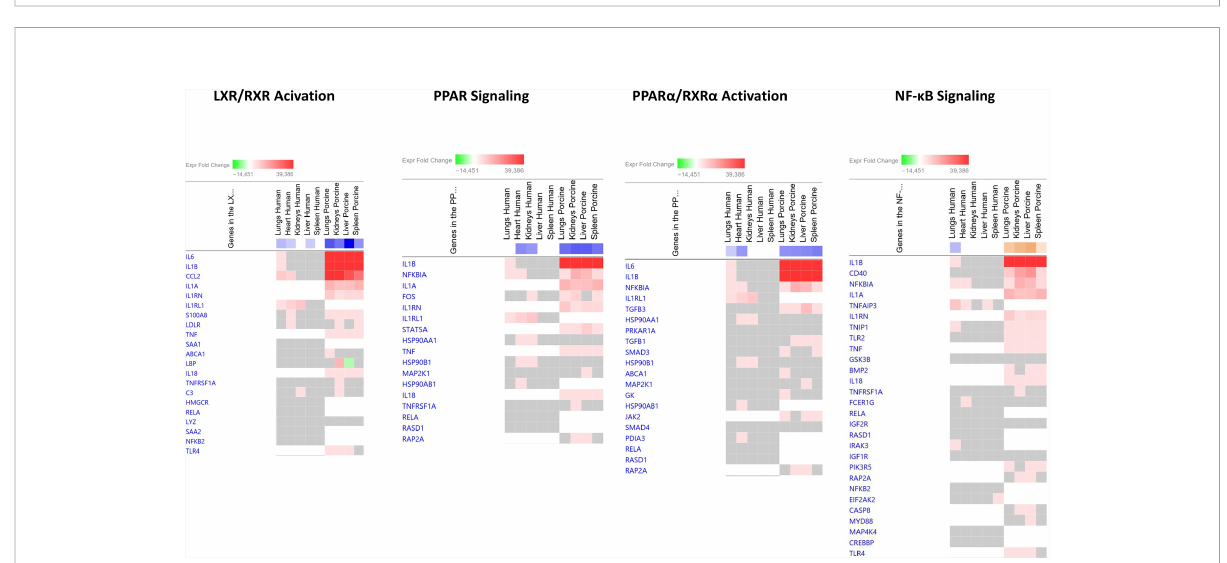
FIGURE 3 Predicted gene signaling pathways from the top downregulated canonical pathways in FFPE tissue samples from patients with meningococcal septic shock and in organs from porcinis infused with exponentially increasing numbers of N. meningitidis (reference strain H44/76) vs. controls.The Z-score indicates predicted activation state of canonical pathways in the tissue samples from meningococcal septic shock patients vs. controls and in organs from porcinis infused with exponentially increasing numbers of N. meningitidis (reference strain H44/76) vs. controls. Orange or lighter shades of orange indicate a positive Z-score and upregulation of the pathway. Blue color or lighter shades of blue indicate a negative Z-score and downregulation of the pathway. The transcripts in the gene signaling pathway are expressed as fold change (FC) values. Red or lighter shades of red indicate positive FC-values and upregulation of transcripts; green color or lighter shades of green indicate negative FC-values and downregulation of transcripts. The color gray indicates that a predicted activation state of a gene/transcript in the canonical pathway signaling network is not affected, the gene/transcript was in the dataset but did not pass the analysis cutoffs. White color indicates that gene/transcript are not present in the